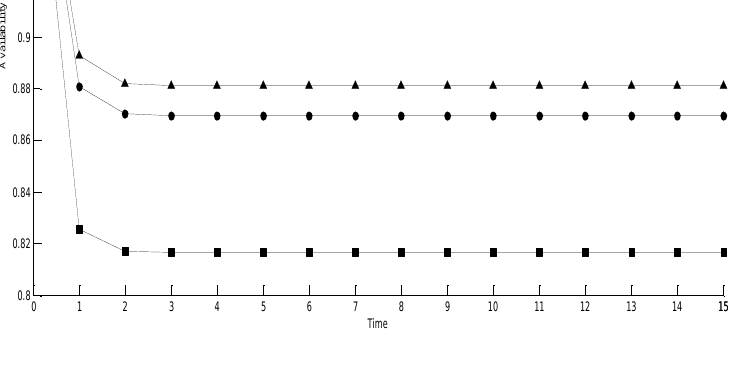
Figure 2. Time vs